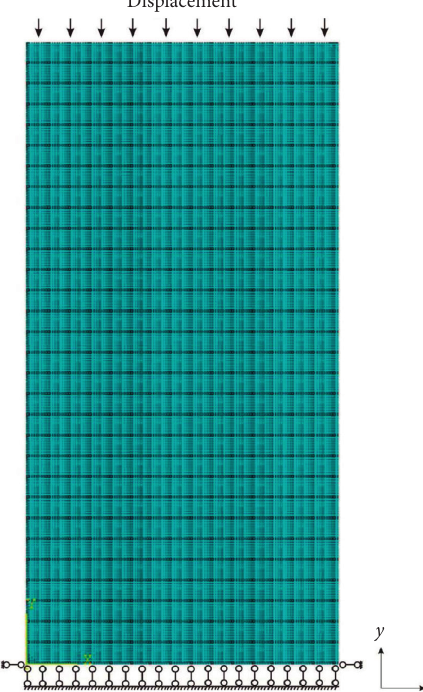
Figure 1: Boundary conditions on the specimen used in this